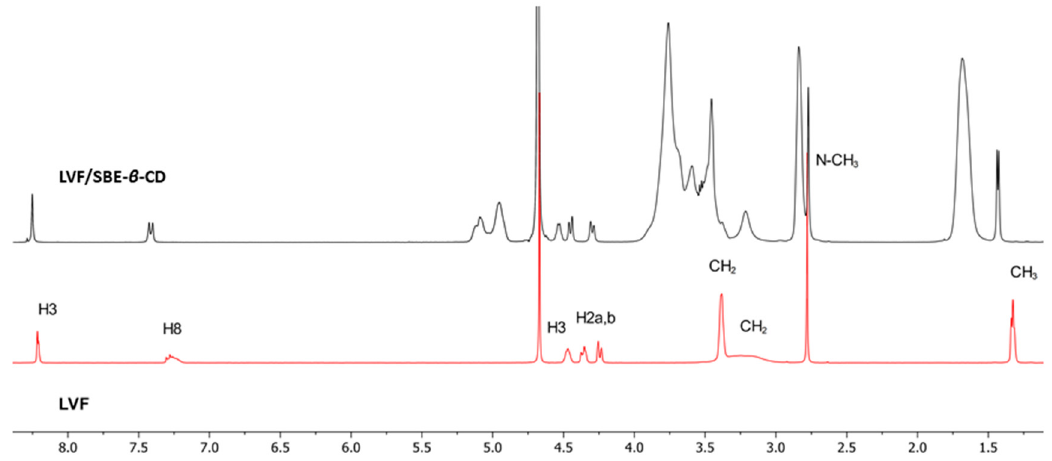
Figure 3. 1 H NMR spectra of LVF/SBE- β -CD inclusion complexes (in black) and LVF (in red). The chemical shift changes of the LVF H2, H3, H5, and H8 protons are diagnostics. Most of the variations of LVF chemical shifts were at δ 4–9 ppm, which was distinct and more evident compared to those of the SBE- β -CD proton (mainly at δ 3–4 ppm). In the LVF/SBE- β -CD inclusion complex, the CIF of H3 LVF proton decreases from 4.47 to 4.54 ppm with the upfield shift of ∆ δ 0.07. Similarly, H5 and H8 LVF protons showed upfield shifts of ∆ δ 0.19 (from 7.28 to 7.48 ppm) and ∆ δ 0.08 (from 8.22 to 8.30 ppm), respectively, after complexation. Furthermore, the CH 3 protons of 1,4-oxazine ring (position 3 of LVF, Figure 1), decrease from 1.32 to 1.41 ppm with the ∆ δ 0.09 upfield shift. For the piperazine CH 2 protons of LVF (Figure 1), the CIF changes are opposed to those of the aromatic ring system, indicating that this ring is outside the SBE- β -CD